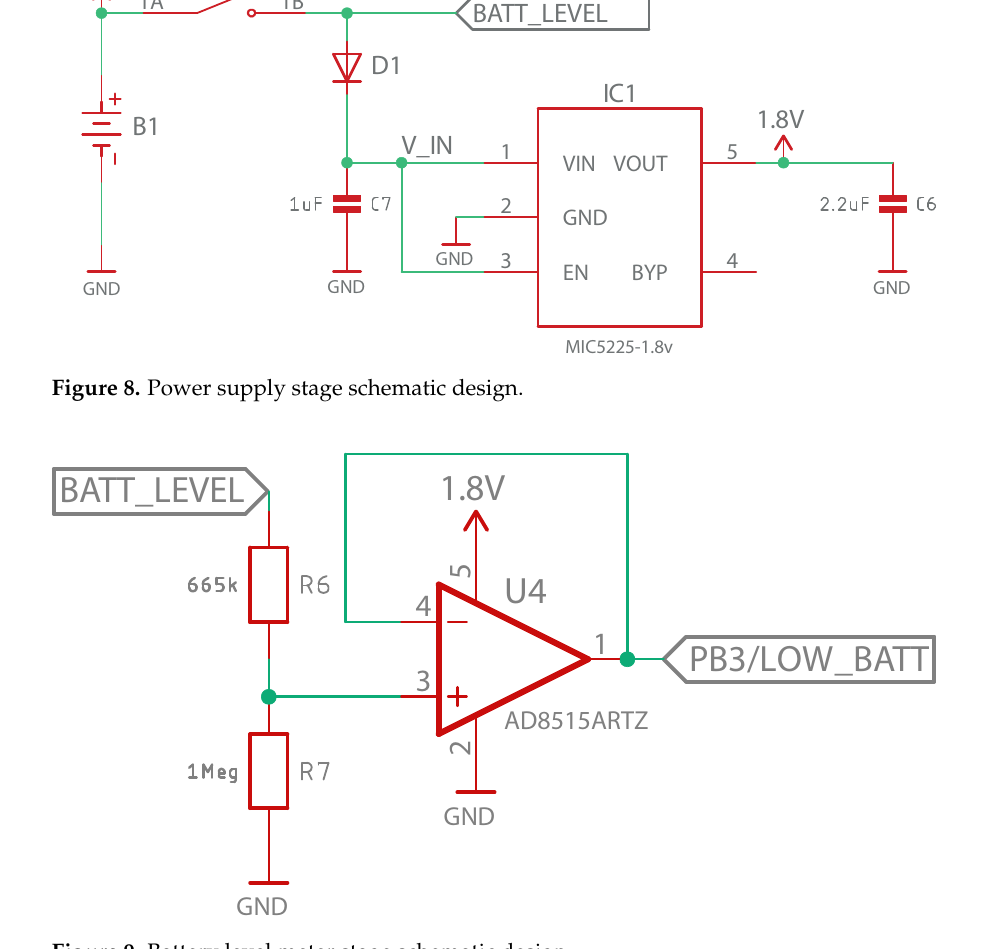
Figure 9. Battery level meter stage schematic